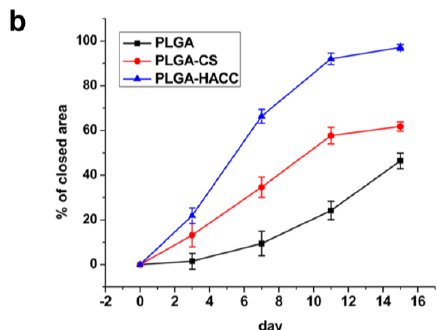
Figure 7. Representative photographs of the S. aureus -infected wound untreated and treated with PLGA, PLGA-CS and PLGA-HACC fibrous membranes after 3, 7, 11 and 15 days ( a ) and their corresponding (quantitatively measured) wound size reduction ( b ).